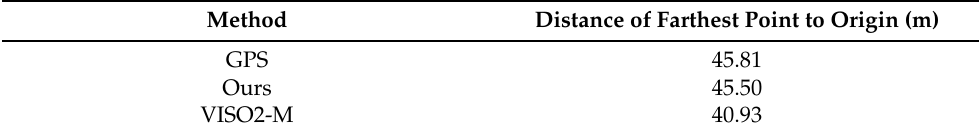
Table 3. Comparison of estimated distance of the farthest point from